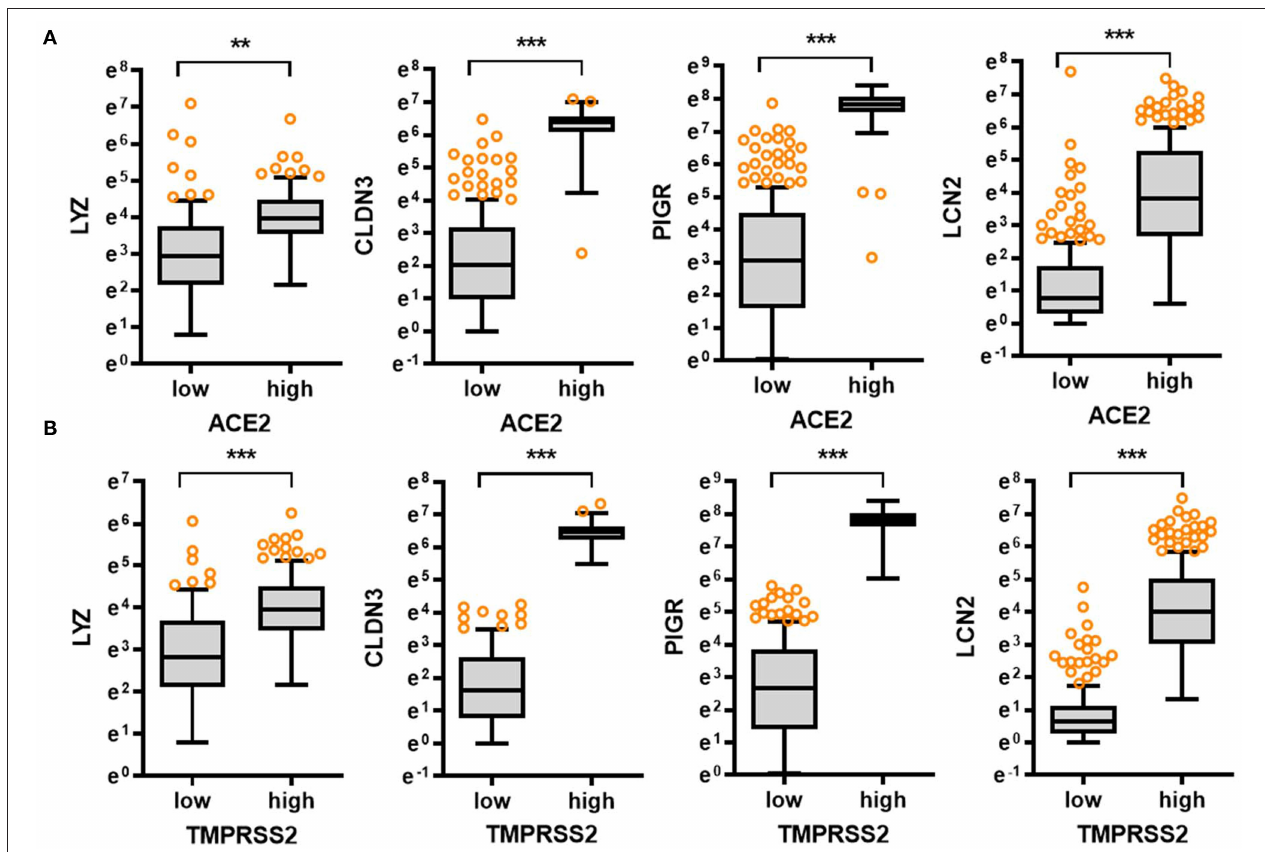
FIGURE 2 | Comparative expression of barrier defense biomarkers with SARS-CoV-2 receptor levels. Based on ACE2 (A) or TMPRSS2 (B) levels in the normal mucosal intestinal tissues (GTEx dataset v8), we selected the 150 highest and 150 lowest level samples, which were further evaluated based on LYZ, CLDN3, PIGR , and LCN2 levels. Values are presented as natural logarithm of transcripts per million (TPM). Asterisks (*) indicate significant differences from the low expression group (** p < 0.01, *** p <